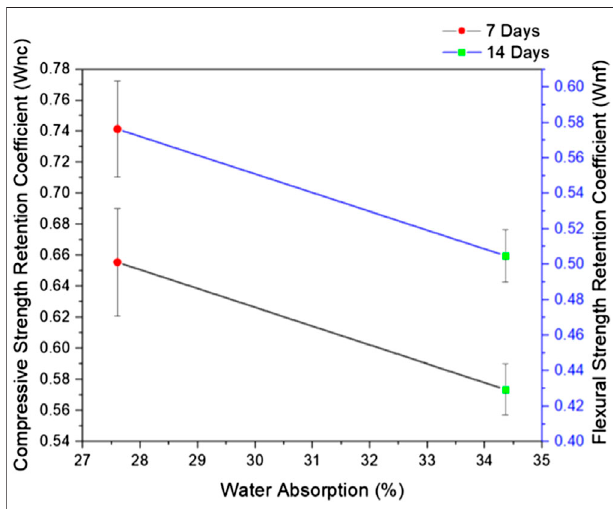
FIGURE 9 | Impact energy of foamed alkali-activated glass according to the international system of units and (ASTM, 2018) with different curing ages.